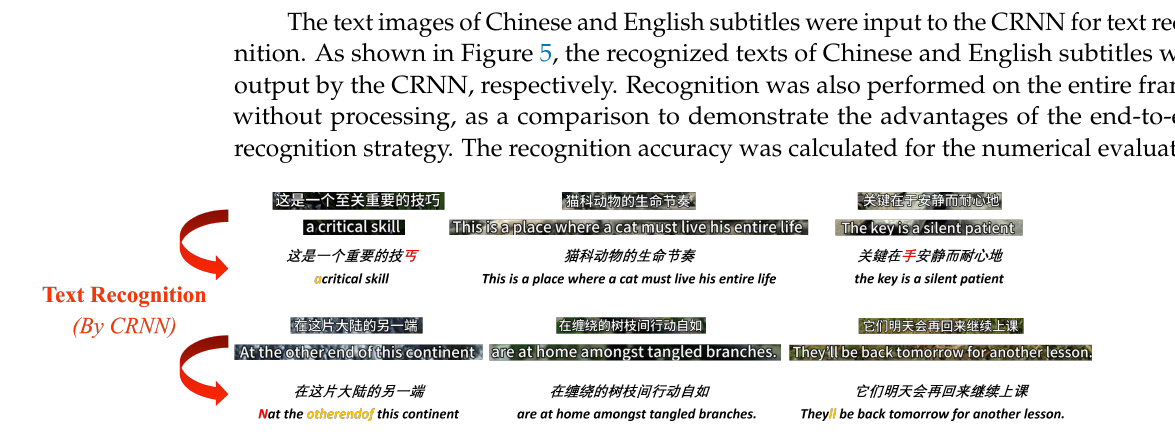
Figure 5. The recognized results of Chinese and English subtitles output by the CRNN.